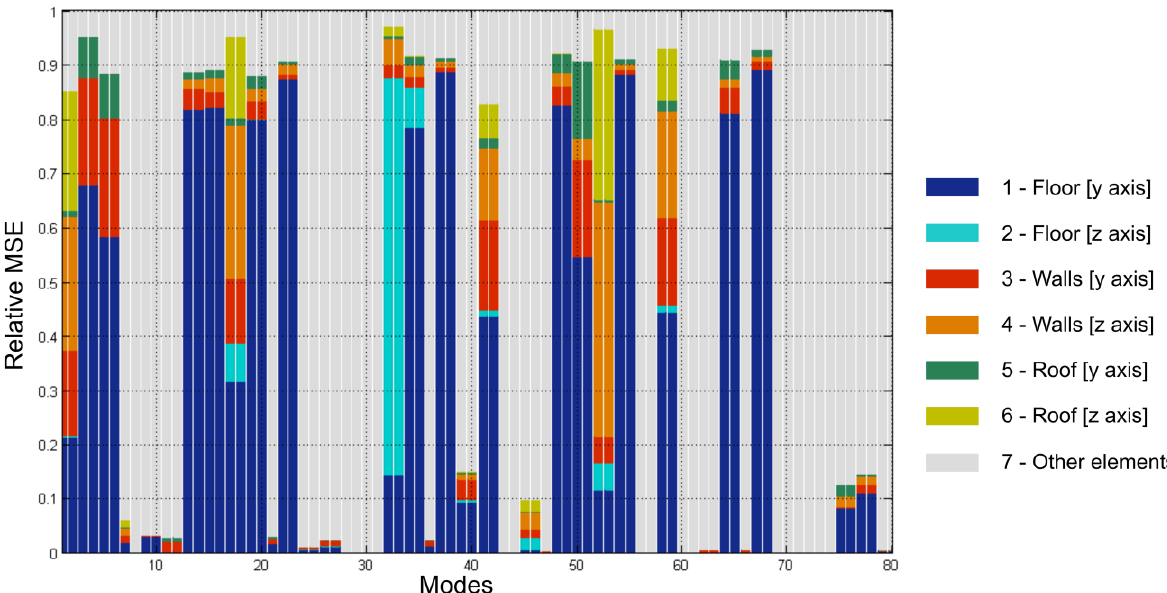
Figure 9. Relative MSE values for the different clusters and vibration modes, obtained based on the numerical model of the BBN vehicle.